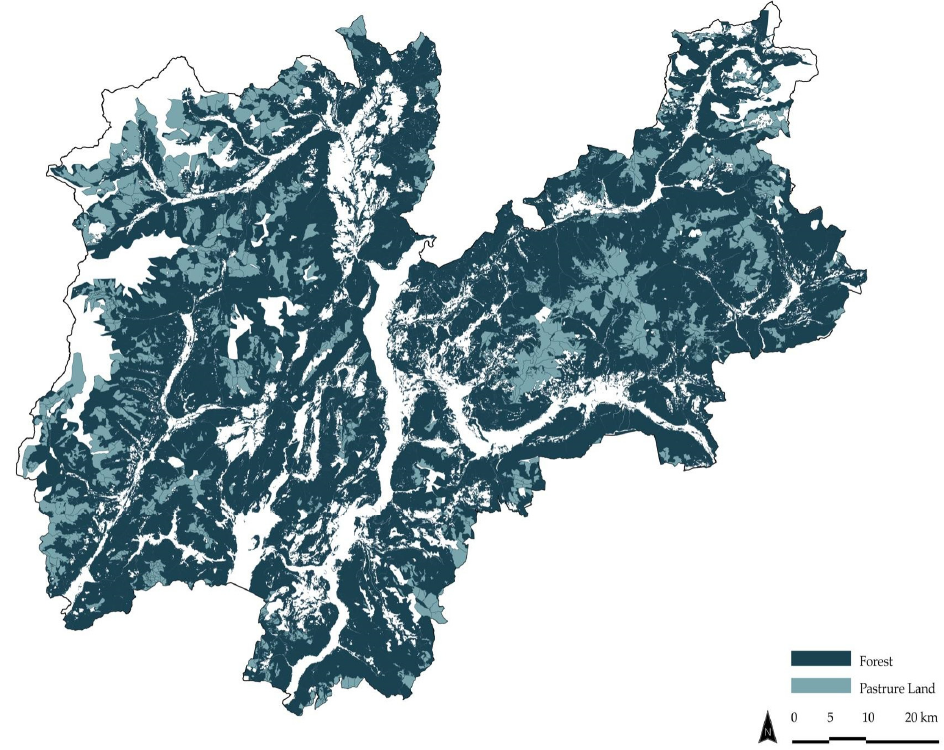
Figure 3. The maps show the spatial distribution, where most of the territory is covered by forests (390,463 hectares, 63% of the provincial surface: https://forestefauna.provincia.tn.it/Foreste, accessed on 25 September 2022), to which pasture meadows (about 35,000 hectares), which are usually collectively owned, have been added (Gis Database: Statistical Service of the Autonomous Province of Trento—data warehouse online, accessed on 25 September 2022. Graphic elaborations by the authors,